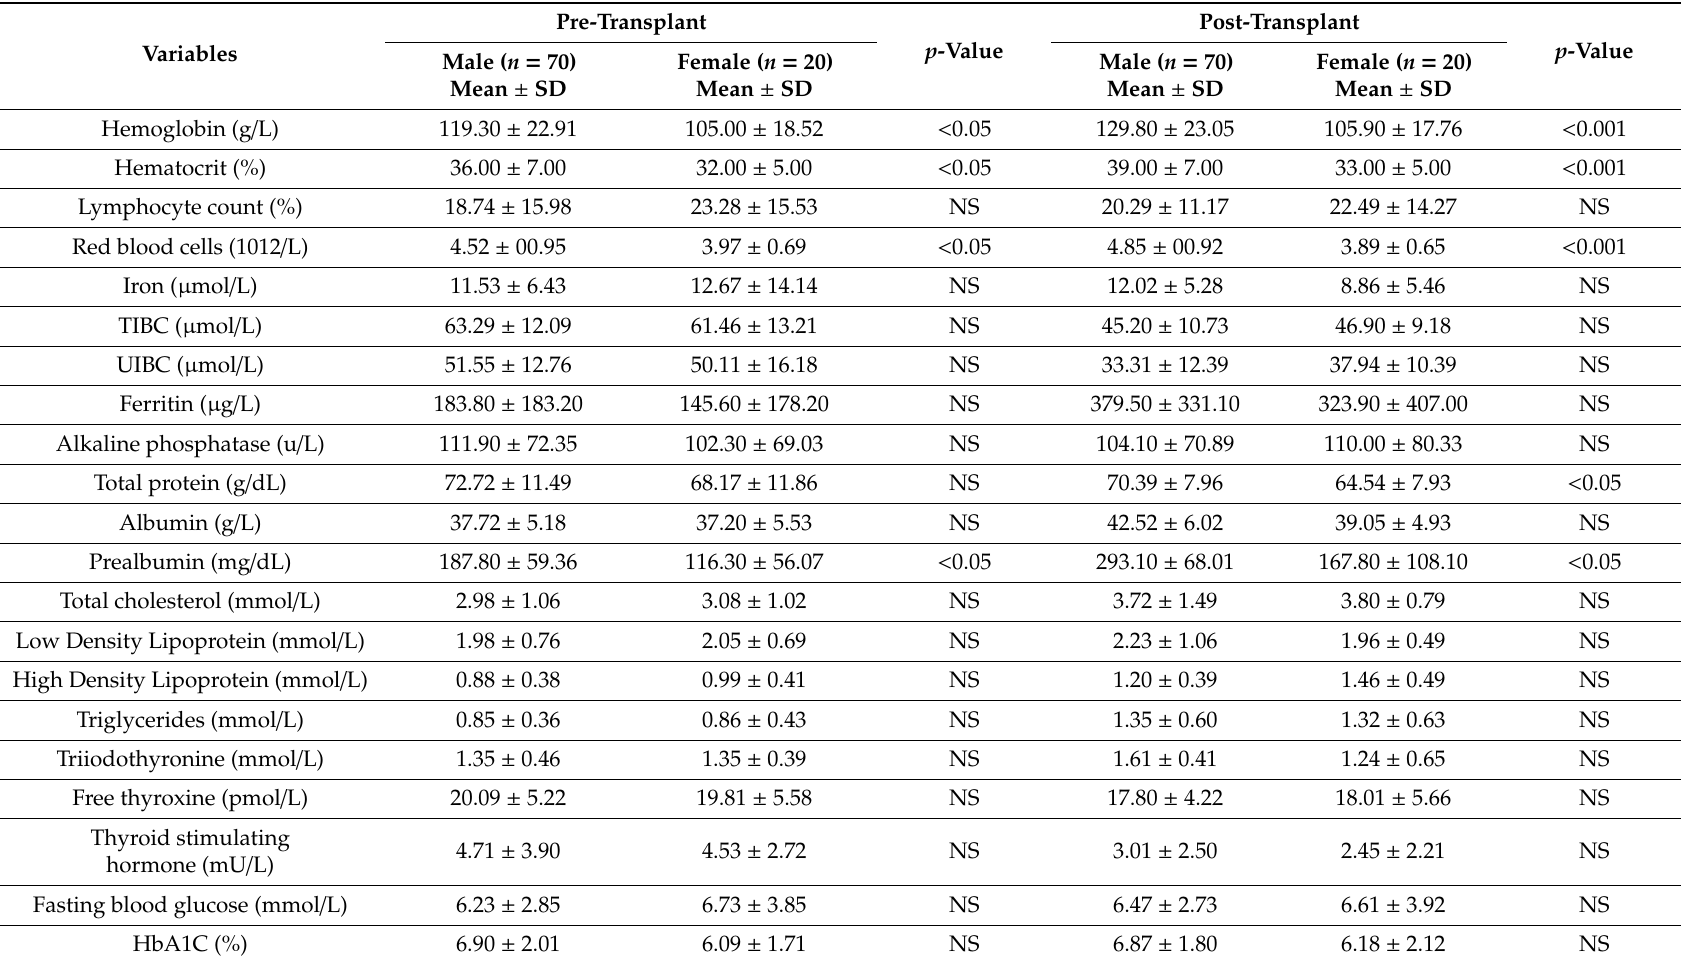
Table 3. Study variables measurements pre- and post-transplantation according to